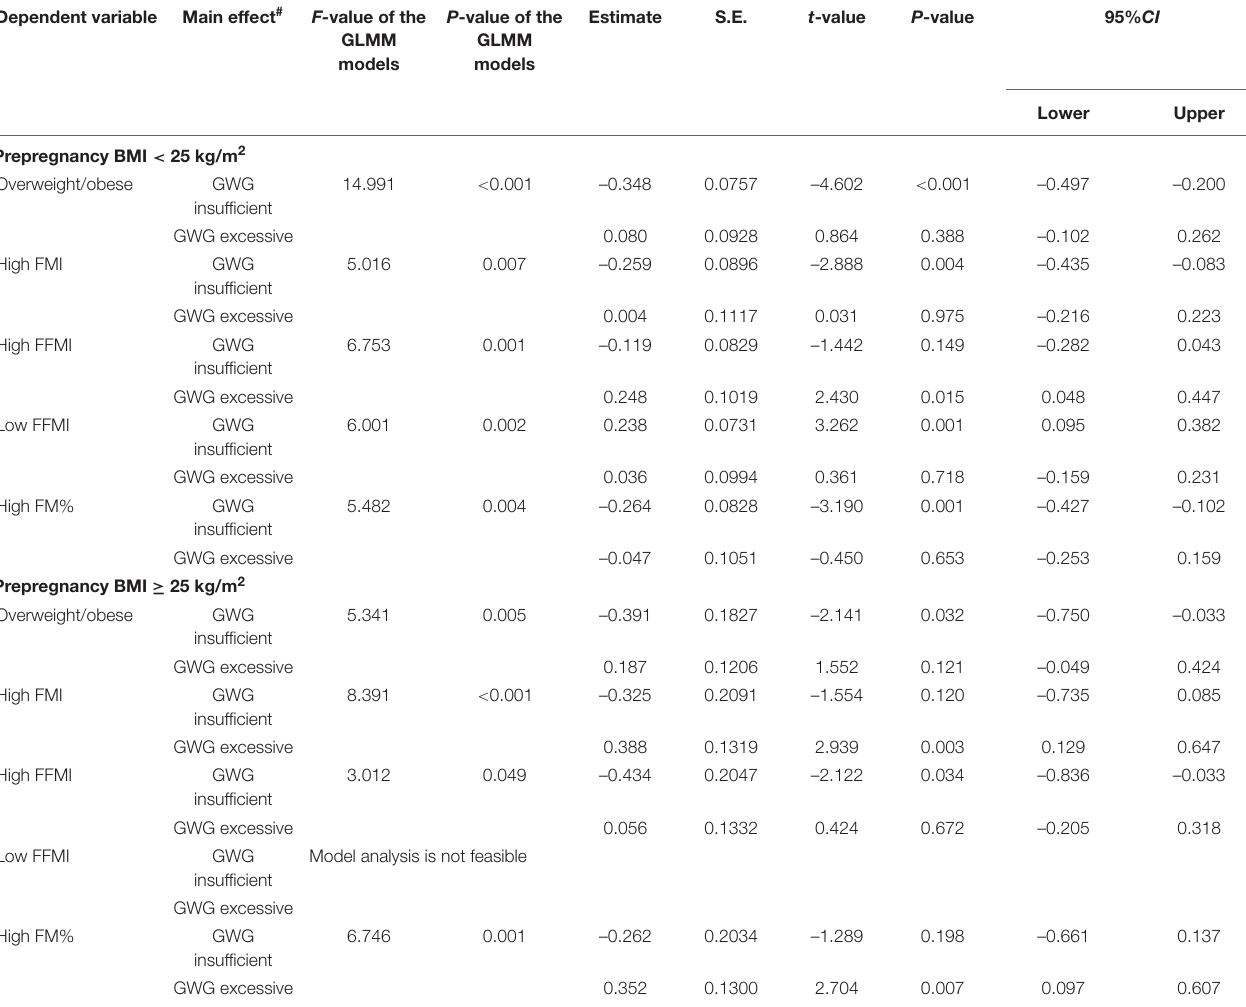
TABLE 5 | Generalized Linear Mixed Models (GLMMs) associations between GWG groups and the adiposity indicators in kindergarten children, stratified by prepregnancy weight